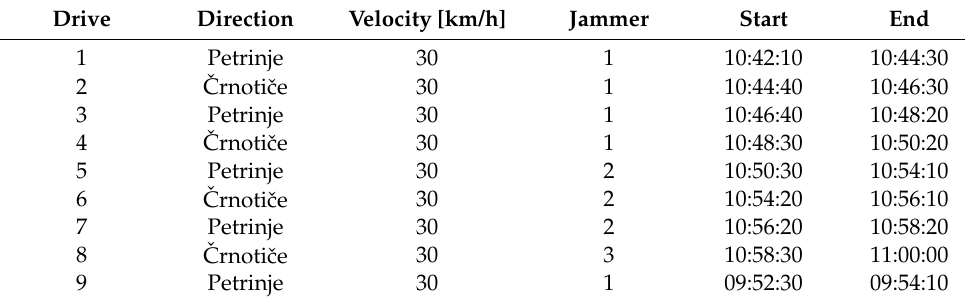
Table 5. Times of drives in UTC; Session 2 of DOY